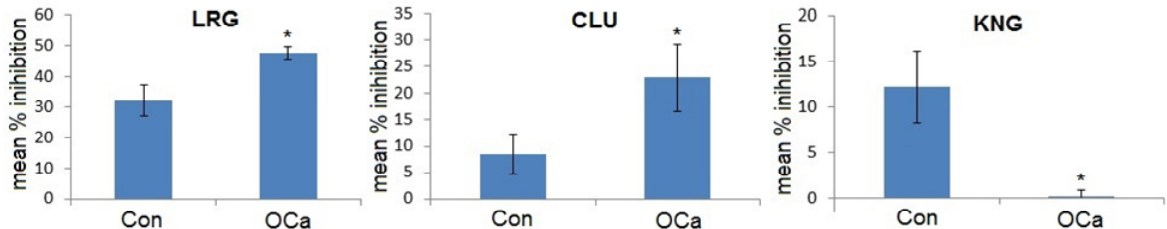
Figure 2. Mean percentage of inhibition of urinary LRG, CLU and KNG in controls (Con) and patients with OCa. Analysis was performed by competitive ELISA. The concentrations of LRG and CLU in the urine samples of OCa patients were significantly higher than those of the controls, while KNG was significantly lower in the OCa patients. The concentrations of proteins present in the samples were proportional to the percentage inhibition of substrate hydrolysis. Asterisk denotes the statistical significance with p <